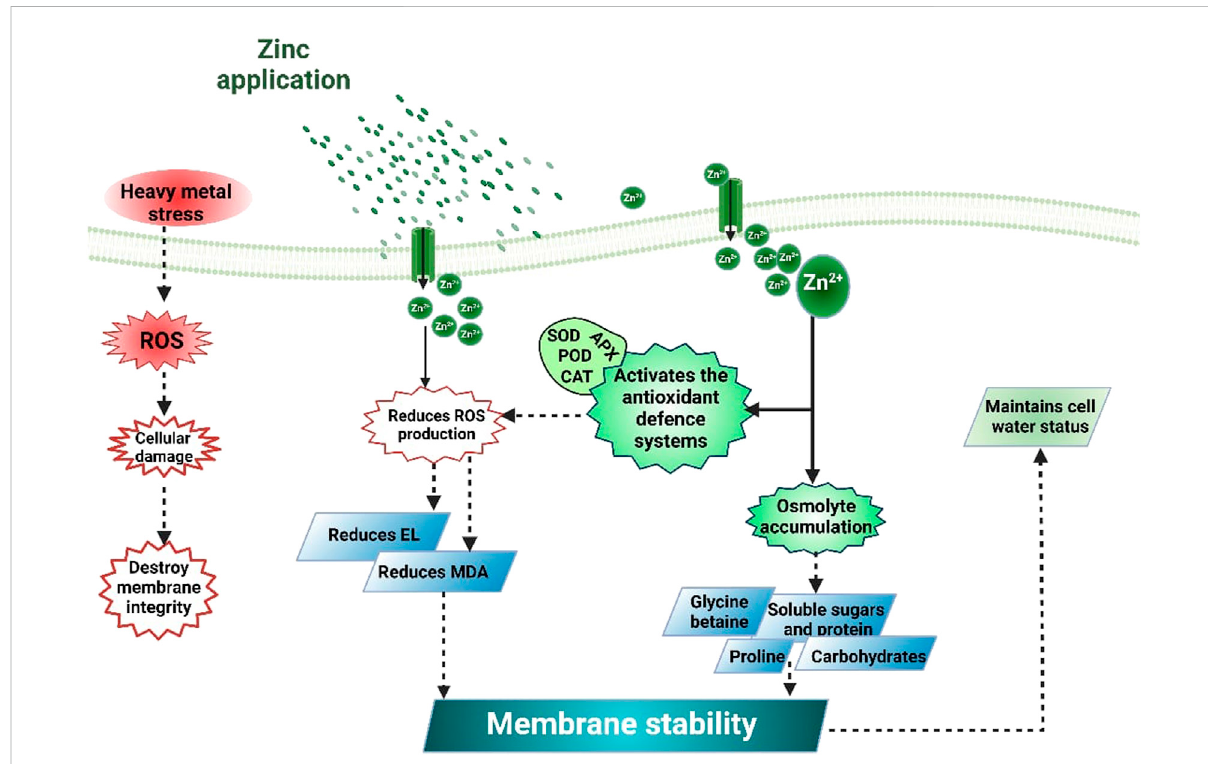
FIGURE 4 Different approaches that can be used to improve Zn accumulation in plants to induce HM stress